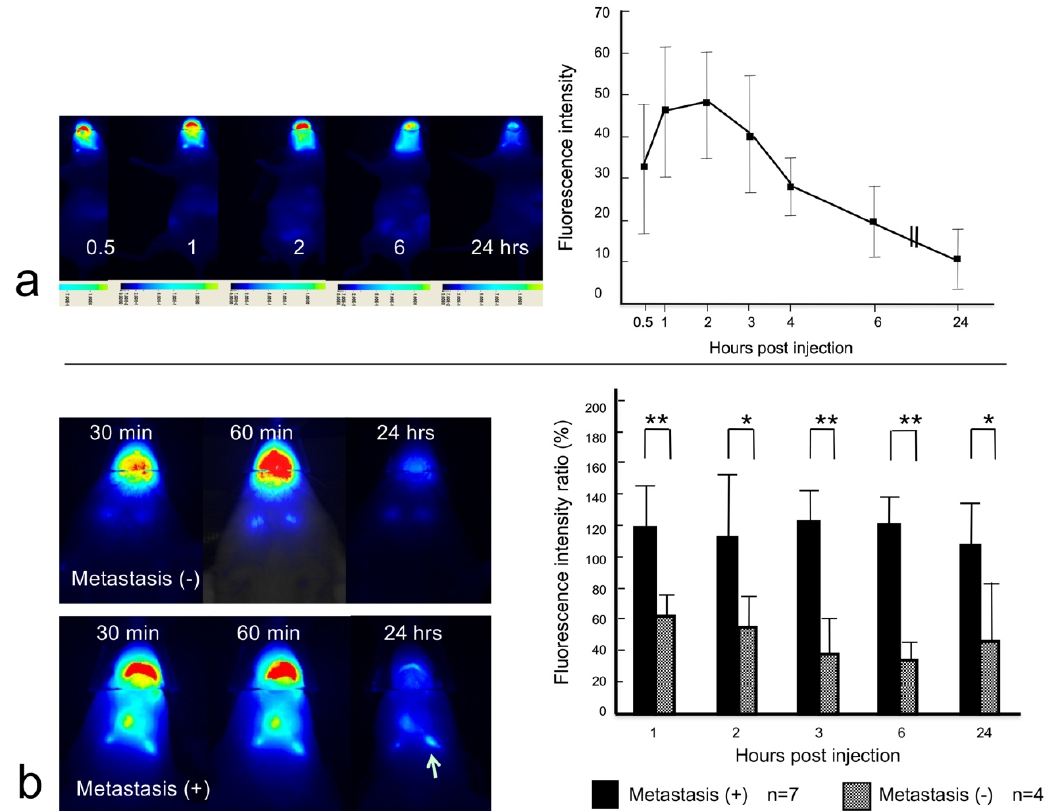
Figure 4. Dynamic imaging study. ( a ) NIR images showed changes in the signal from the anti-EGFR affibody probe in the lymph nodes of a normal control mouse (left). The fluorescence signal intensity was examined at 0.5, 1, 2, 3, 4, 6, and 24 h after the tongue injection in two mice (total four lymph nodes). The peak intensity was observed at one and two hours after the injection (right). The error bar shows the standard deviation. ( b ) The left panels are images of metastatic and nonmetastatic lymph nodes. Weak, almost equal NIR signal intensity was found in two nonmetastatic lymph nodes at 0.5 and 1 h post-injection. The signal intensity almost disappeared at 24 h after the injection (top, left). A high signal intensity remained in the metastatic lymph node (arrow) at 24 h after injection (bottom, left). The time-dependent NIR signal intensity of the anti-EGFR affibody probe is represented as a percentage of the initial signal intensity (30 min). The signal intensity ratio was greater for metastatic lymph nodes than nonmetastatic lymph nodes at 1, 2, 3, and 6 h after the injection (right panel). * p < 0.05; ** p < 0.01. The error bar shows the standard deviation.